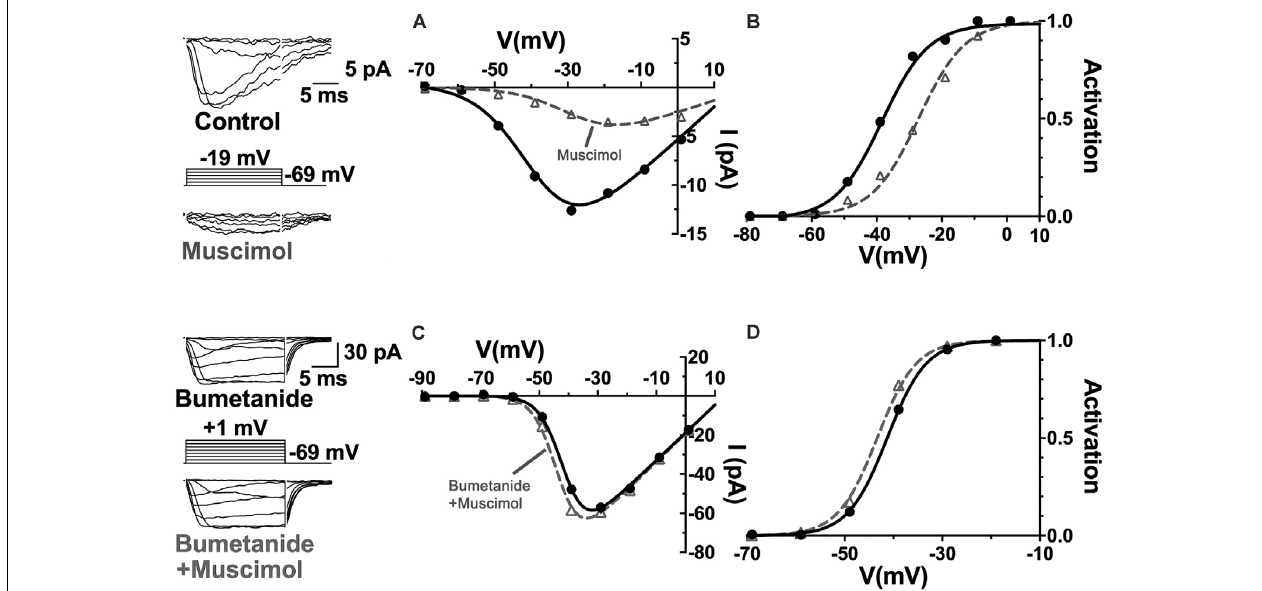
FIGURE 9 | The NKCC blocker bumetanide eliminates the muscimol-induced activation curve shift of cone Ca V channels. (A) I–V relations with smaller Ca V channel currents were produced in the presence of muscimol, which is accounted for by the strong rightward shift of the Ca V channel activation curve midpoint (B) . (C) Same experimental paradigm as above but slices superfused with bumetanide for 30 min. Ca V channel currents in the absence and presence of muscimol produced I–V relations and activation curves having only a slight leftward activation midpoint shift with muscimol in bumetanide-treated retinas (D) . Figure modified from Grove et al.